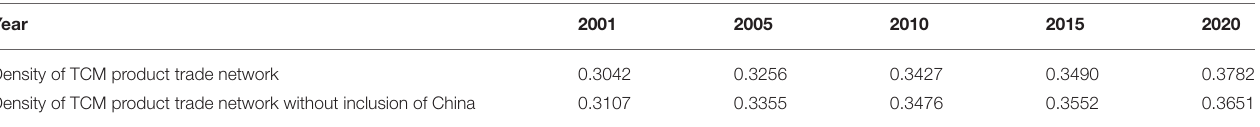
TABLE 5 | China’s impact on trade network in